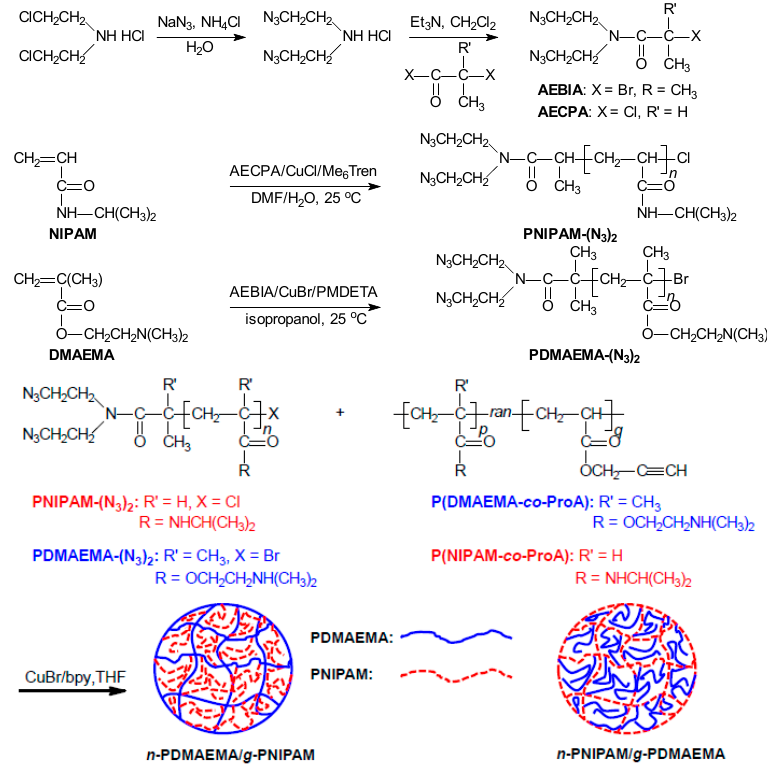
Scheme 1. Schematic preparation of thermo- and pH-sensitive network-graft hydrogels of PNIPAM and PDMAEMA.